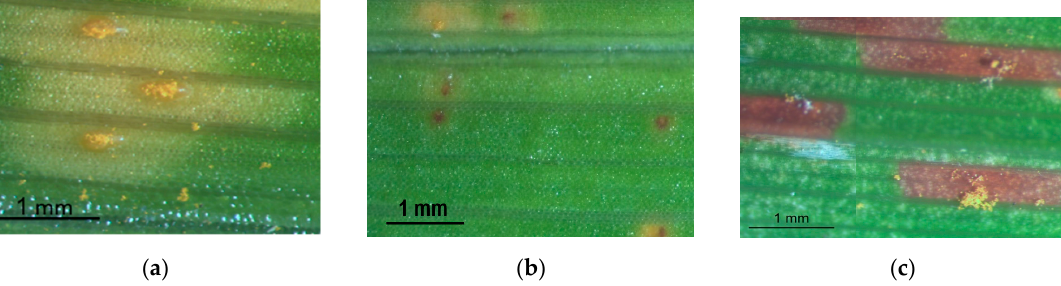
Figure 5. Daylily rust symptoms and signs obtained in susceptible, moderately susceptible and moderately resistant interactions: ( a ) Uredia and urediniospores on the under surface of the leaf in susceptible Hemerocallis , observed 7 dai; ( b ) Chlorosis, uredia and small necrotic lesions on the under surface of the leaf in moderately susceptible Hemerocallis , observed 16 dai; ( c ) Necrotic lesions on the under surface of the leaf in moderately resistant Hemerocallis with urediniospores 30 dai. The cultivars that had the longest latent period were the moderately resistant and moderately susceptible cultivars that had a smaller latent period (Table